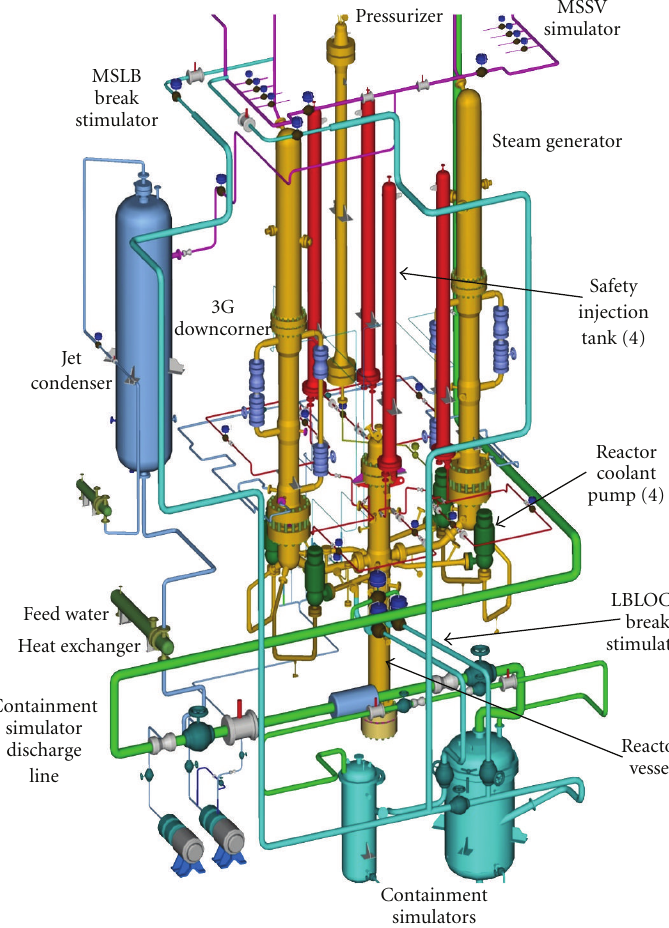
Figure 1: Schematic arrangement of the major components of